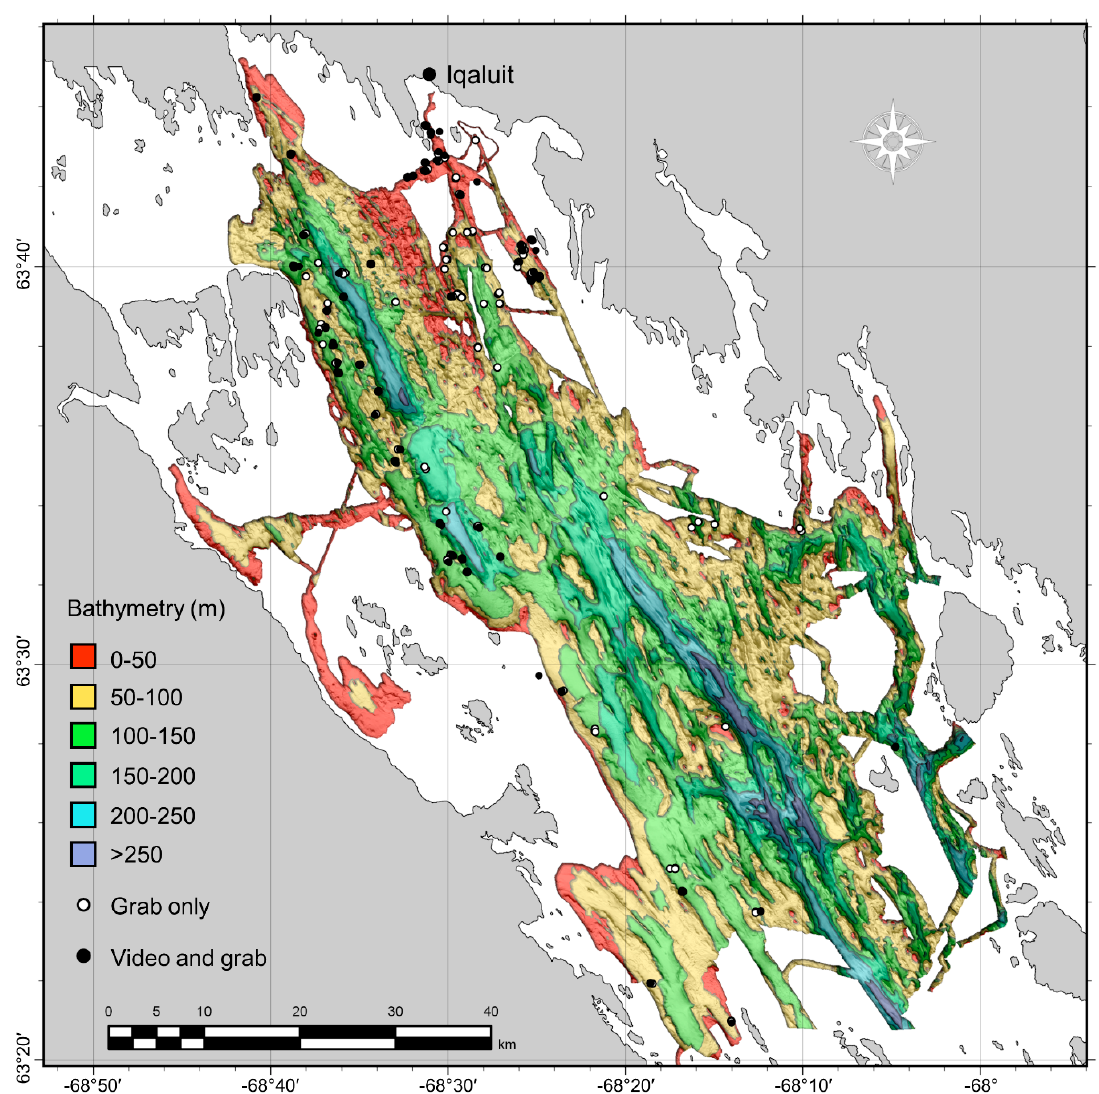
Figure 4. Inner Frobisher Bay multibeam echosounder (MBES) bathymetry contoured at 50 m with shaded terrain and sample sites.